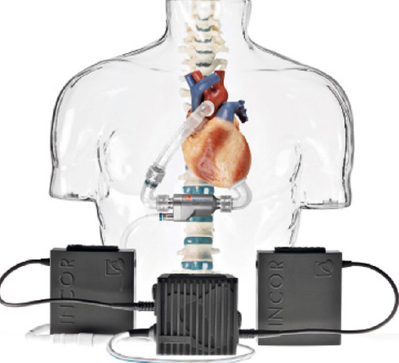
Fig. 5 - Berlin Heart INCOR® (Berlin Heart, www.berlinheart.com).